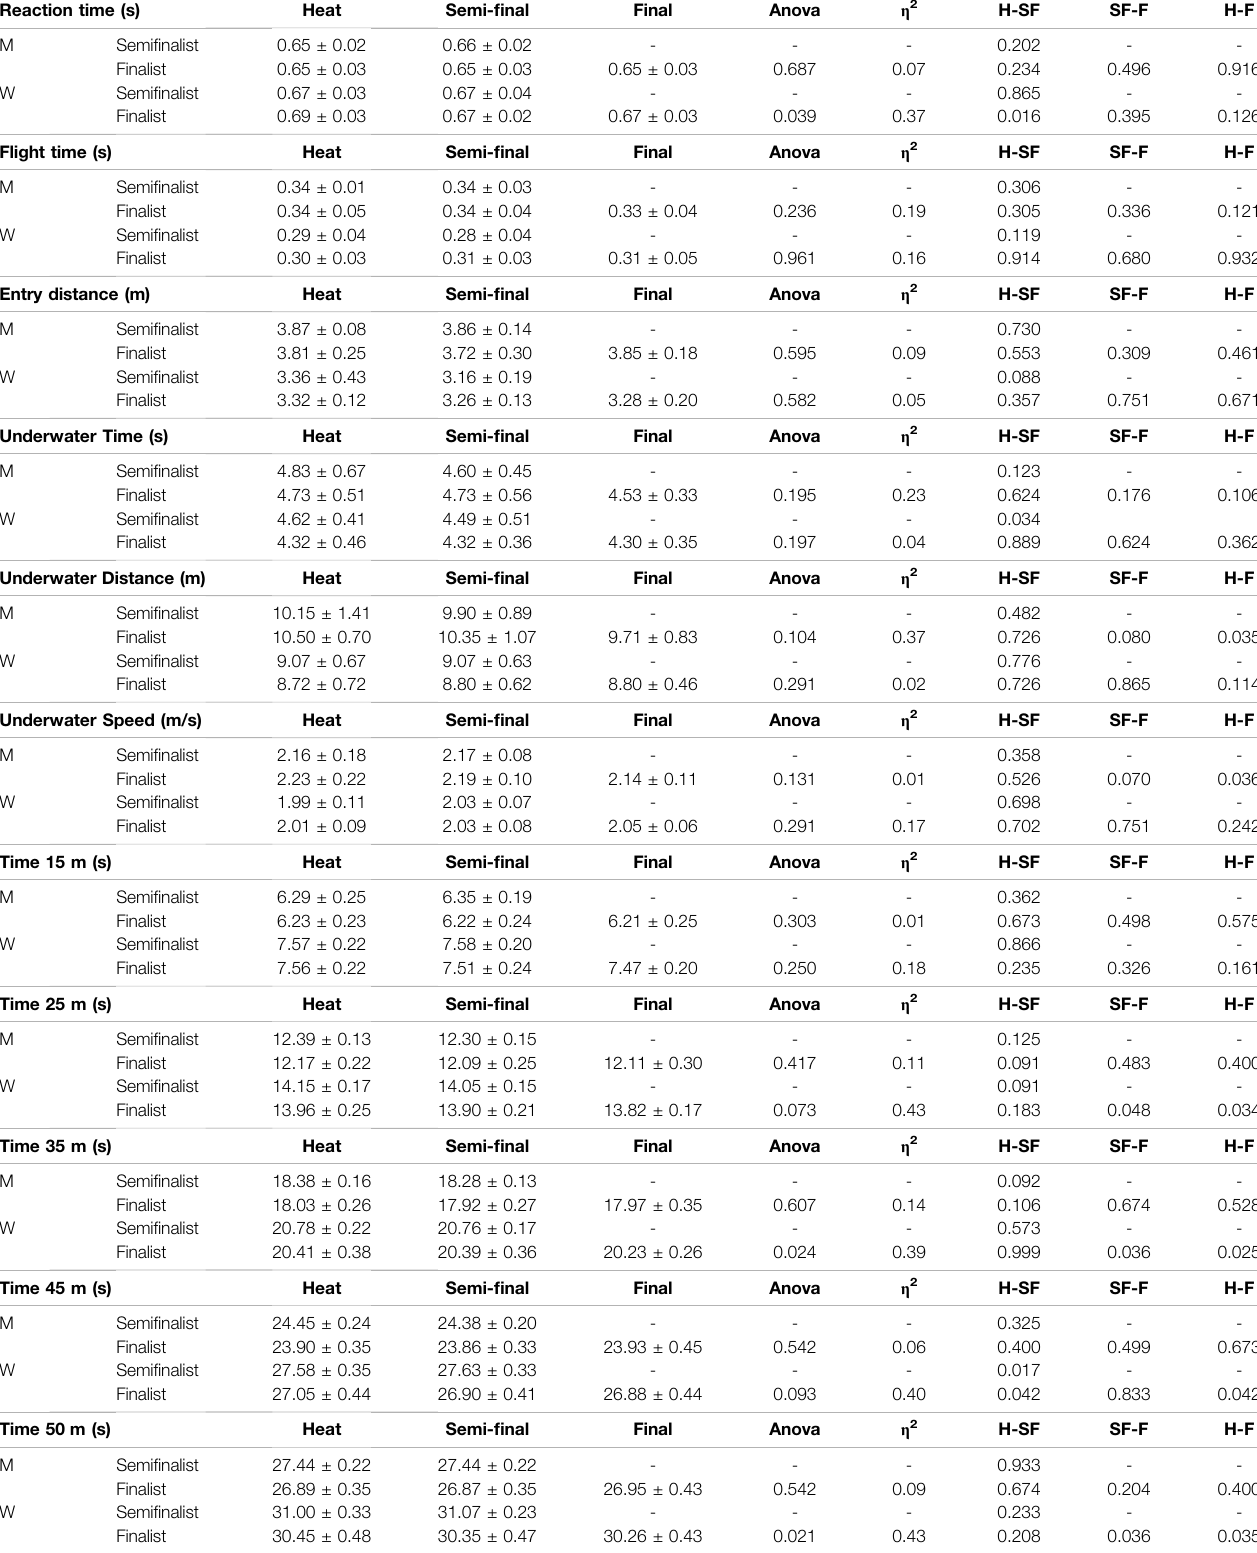
TABLE 3 | Breaststroke performance variables ’ results, p values, and effect sizes ( η 2 ) between the different three rounds. Men (M); Women (W) (LEN European Senior Championships 2021). Reaction time